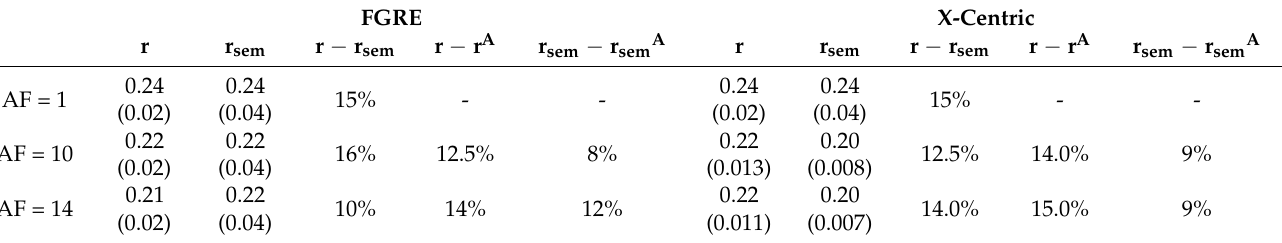
r = MRI mean fractional ventilation estimate obtained with the Deninger method using fully sampled data; r sem = MRI mean fractional ventilation estimate obtained with SEM using fully sampled data; r A = MRI mean frac- tional ventilation estimate obtained with the Deninger method using accelerated data; r semA = MRI mean fractional